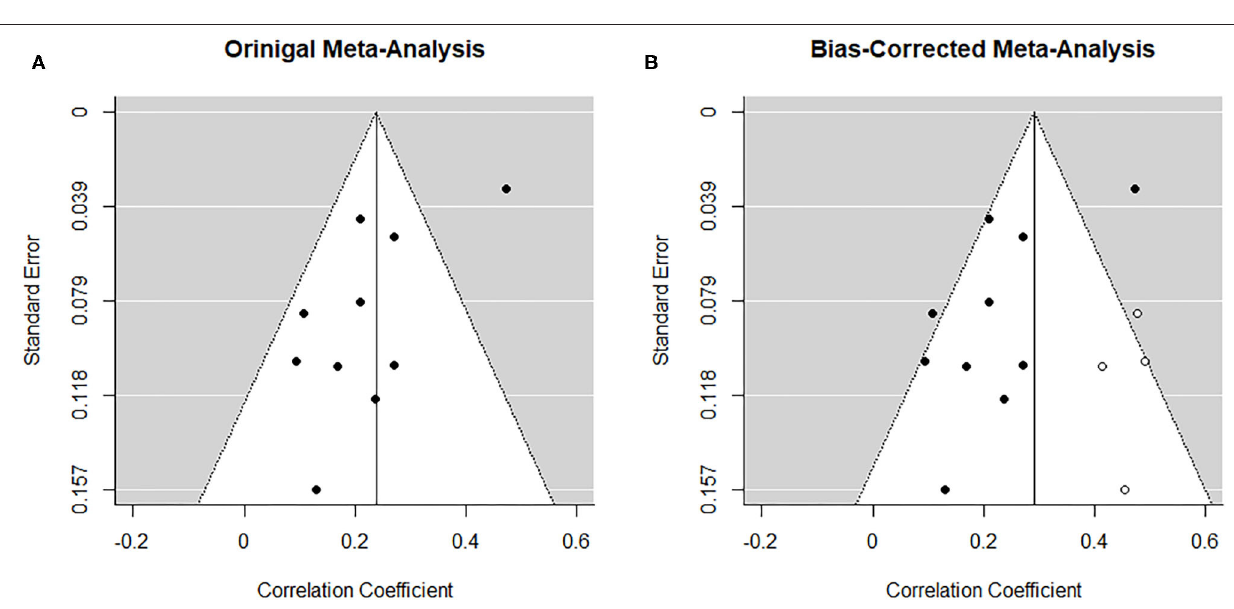
Frontiers in Psychiatry | www.frontiersin.org